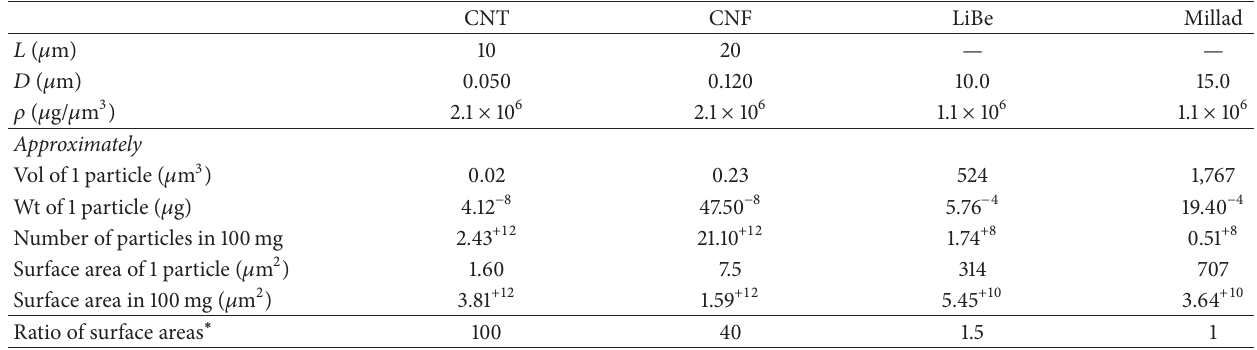
Table 1: Comparison of size and surface area of the four different nucleating